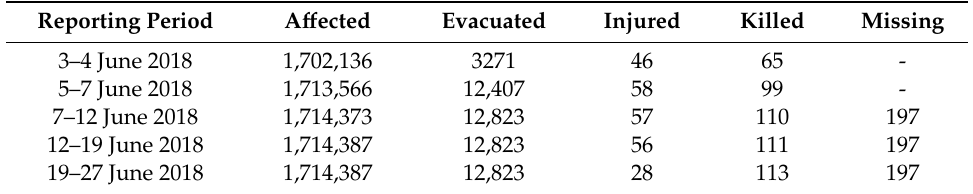
Table 1. Information from reports issued by OCHA, which were produced in collaboration with information provided by the National Coordinator for Disaster Reduction (CONRED), INSIVUMEH, the UN Emergency Technical Team (UNETE), the Red Cross, and other Non-Governmental Organizations. The first report was issued less than 24 h after the